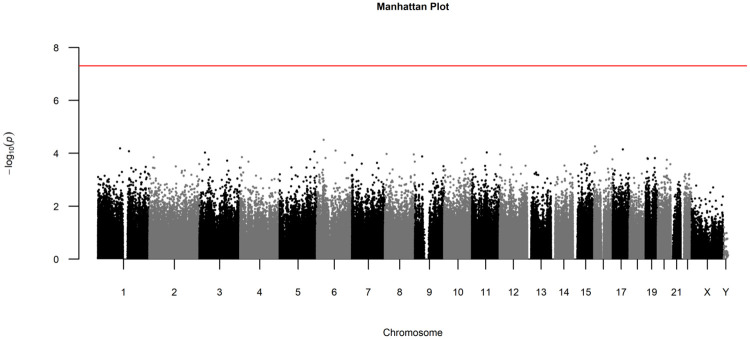
Manhattan plot of DMP analysis with all probes in association with ΔDAS28.Associations were adjusted for age, gender, smoking and cell type ratios. The red line indicates genome-wide significance according to Bonferroni correction (p-value = 5.91−8).